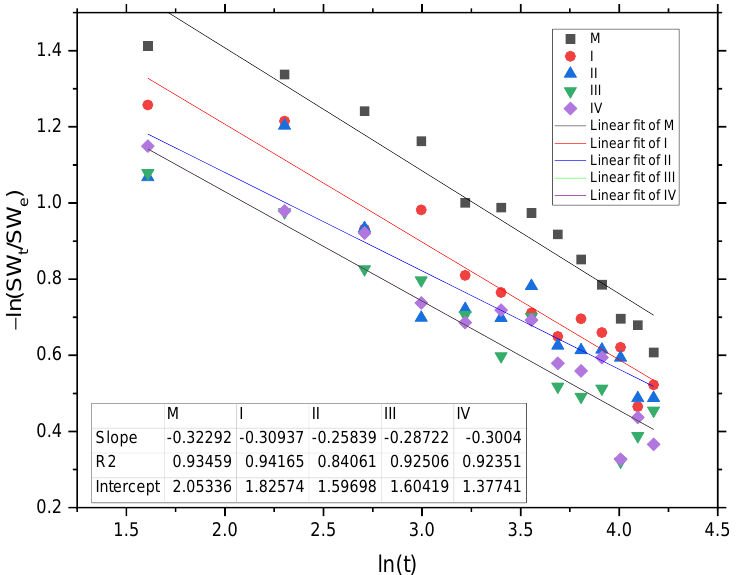
Figure 3. The plot of − ln (SWt/SWe) against ln (t) for control sample (M) and the ones containing increasing concentrations of graphene oxide (I, II, III, and IV) for swelling degree < 60%. The diffusion process over the whole time interval follows the non-Fickian model, of order two, evaluated with Schott’s equation, as represented in Figure 4.